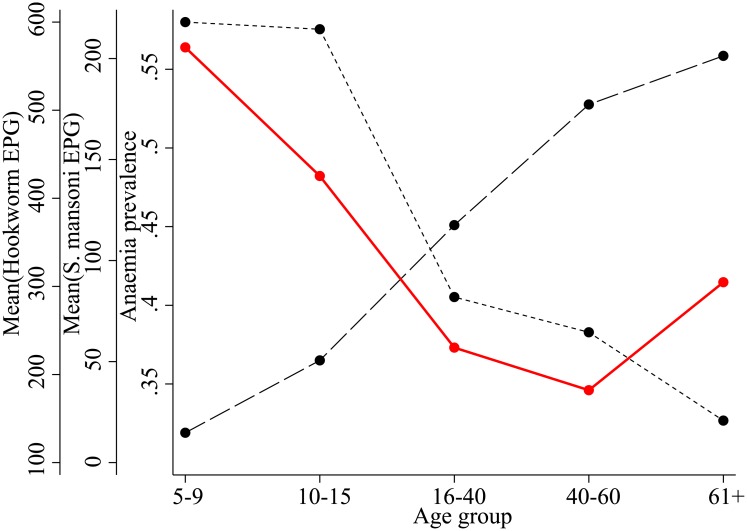
Overlaid plot of S. mansoni and hookworm infection intensities and anaemia prevalence against age.The first axis and red line (solid line) represent anaemia prevalence for each age group. The second axis and short dashed line portray the arithmetic mean of S. mansoni eggs per gram (EPG) for each age group. Similarly, the third axis and long-dashed line represent the arithmetic mean of hookworm EPG by age group.